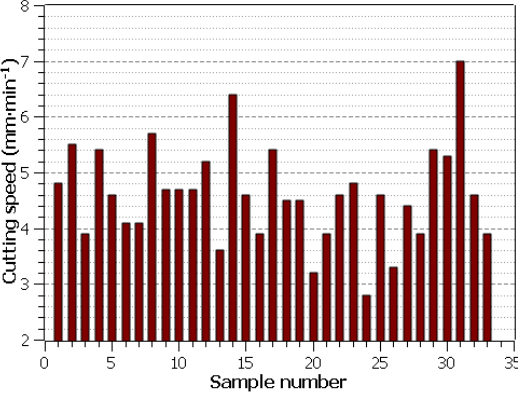
Figure 3. Thecutting speed of individual samples.